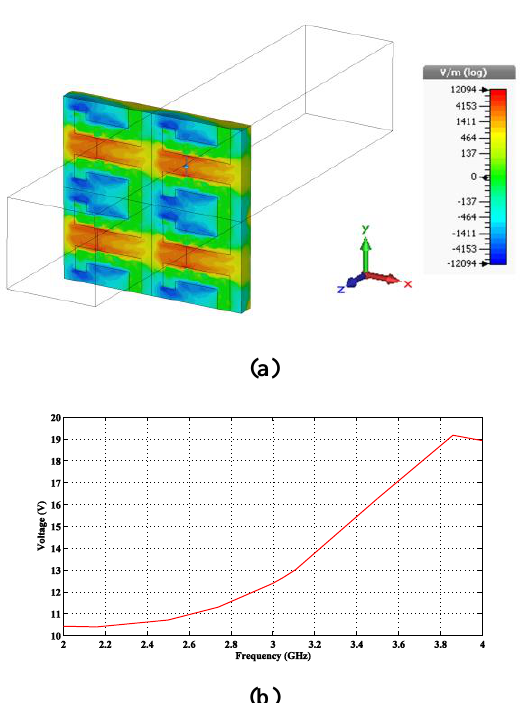
Figure 7: Magnitude of the electric field E y distribution on eSRR when the diodes are off (a) and induced voltage across diodes with an incident power intensity equal to 0.5 watts